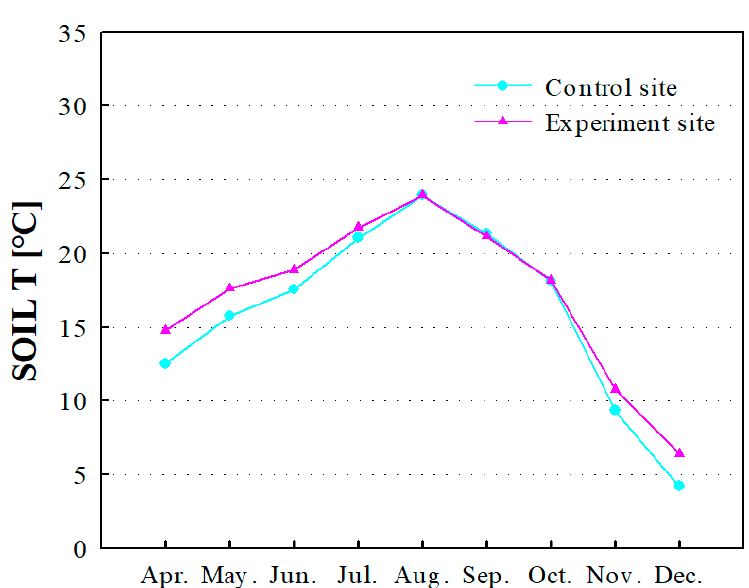
Figure 19. Temperature comparison.